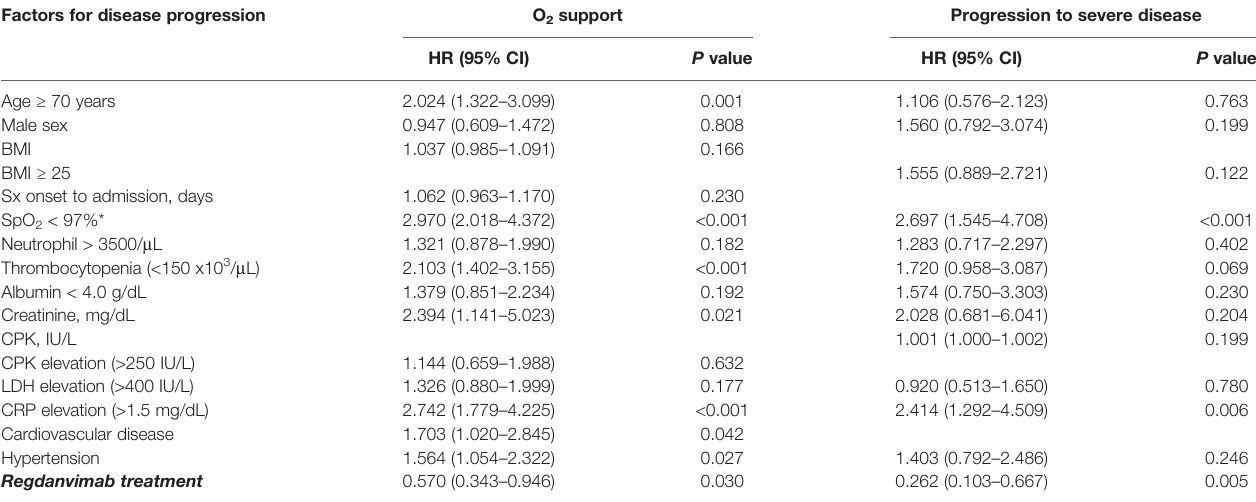
TABLE 3 | Multivariate analysis of 21-day disease progression